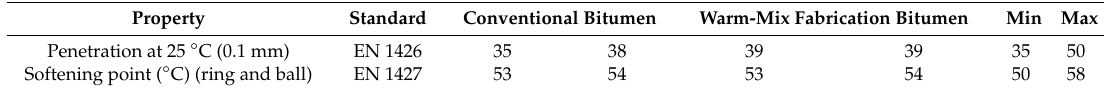
Table 3. Results of the bitumen tests.